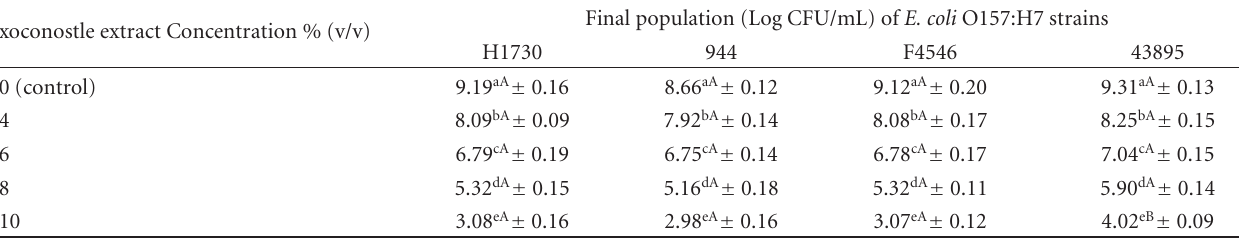
∗ Averages with di ff erent lower case letters in the same column are significantly di ff erent ( P < 0 . 05). ∗ Averages with di ff erent upper case letters in the same row are significantly di ff erent ( P < 0 .